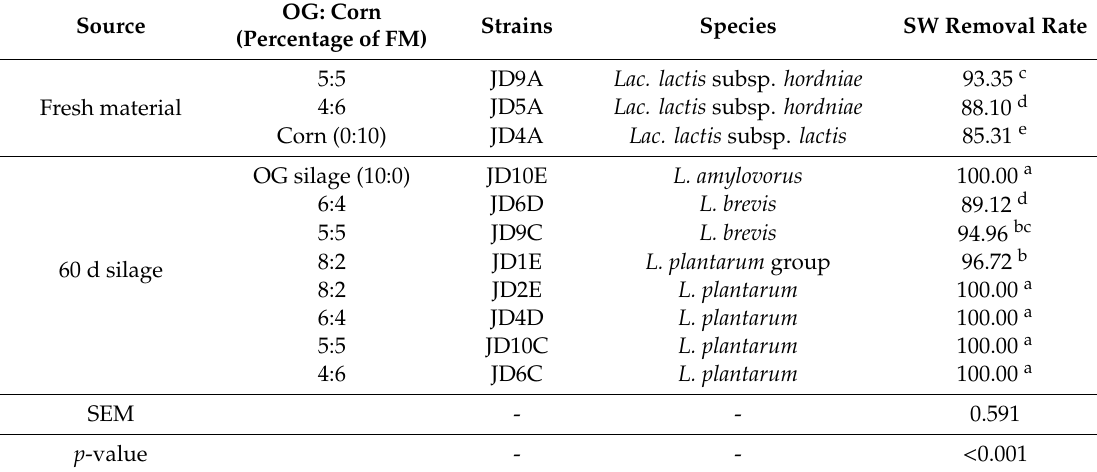
Table 5. Swainsonine (SW) removal rate (%) in Oxytropis glabra (OG) broth by representative LAB strains of di ff erent